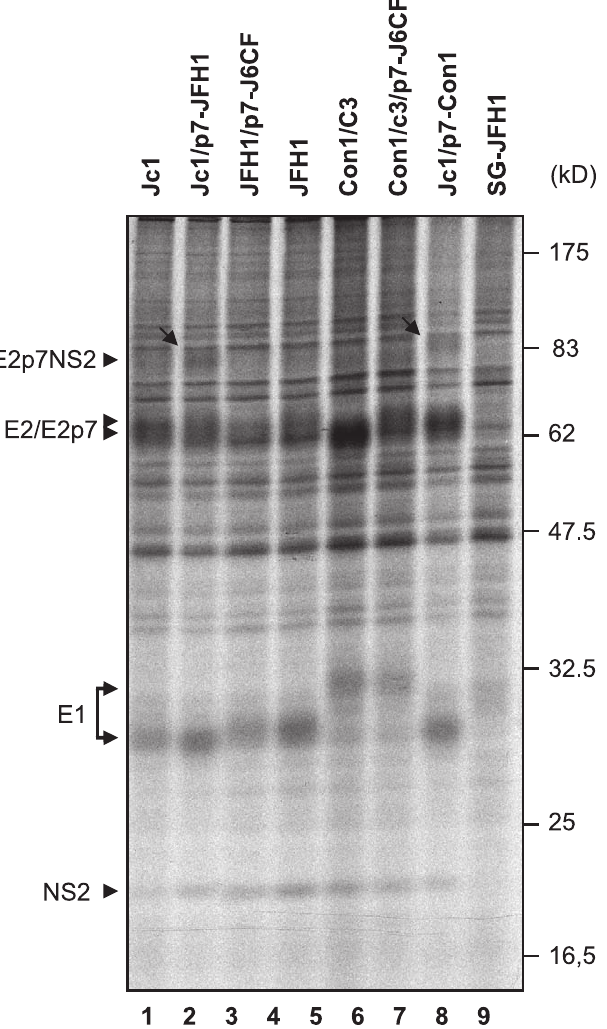
Figure 6. Accumulation of Infectivity upon Transfection of GT 2a and GT 1b Viruses with J6CF-Derived p7 Proteins The color coding is as in Figure 1 with open boxes representing JFH1, gray boxes J6CF, and black boxes Con1 proteins. Accumulation of infectivity upon transfection is given below. The gray line denotes the detection limit of the limiting dilution assay. A representative experiment of at least two repetitions is depicted.